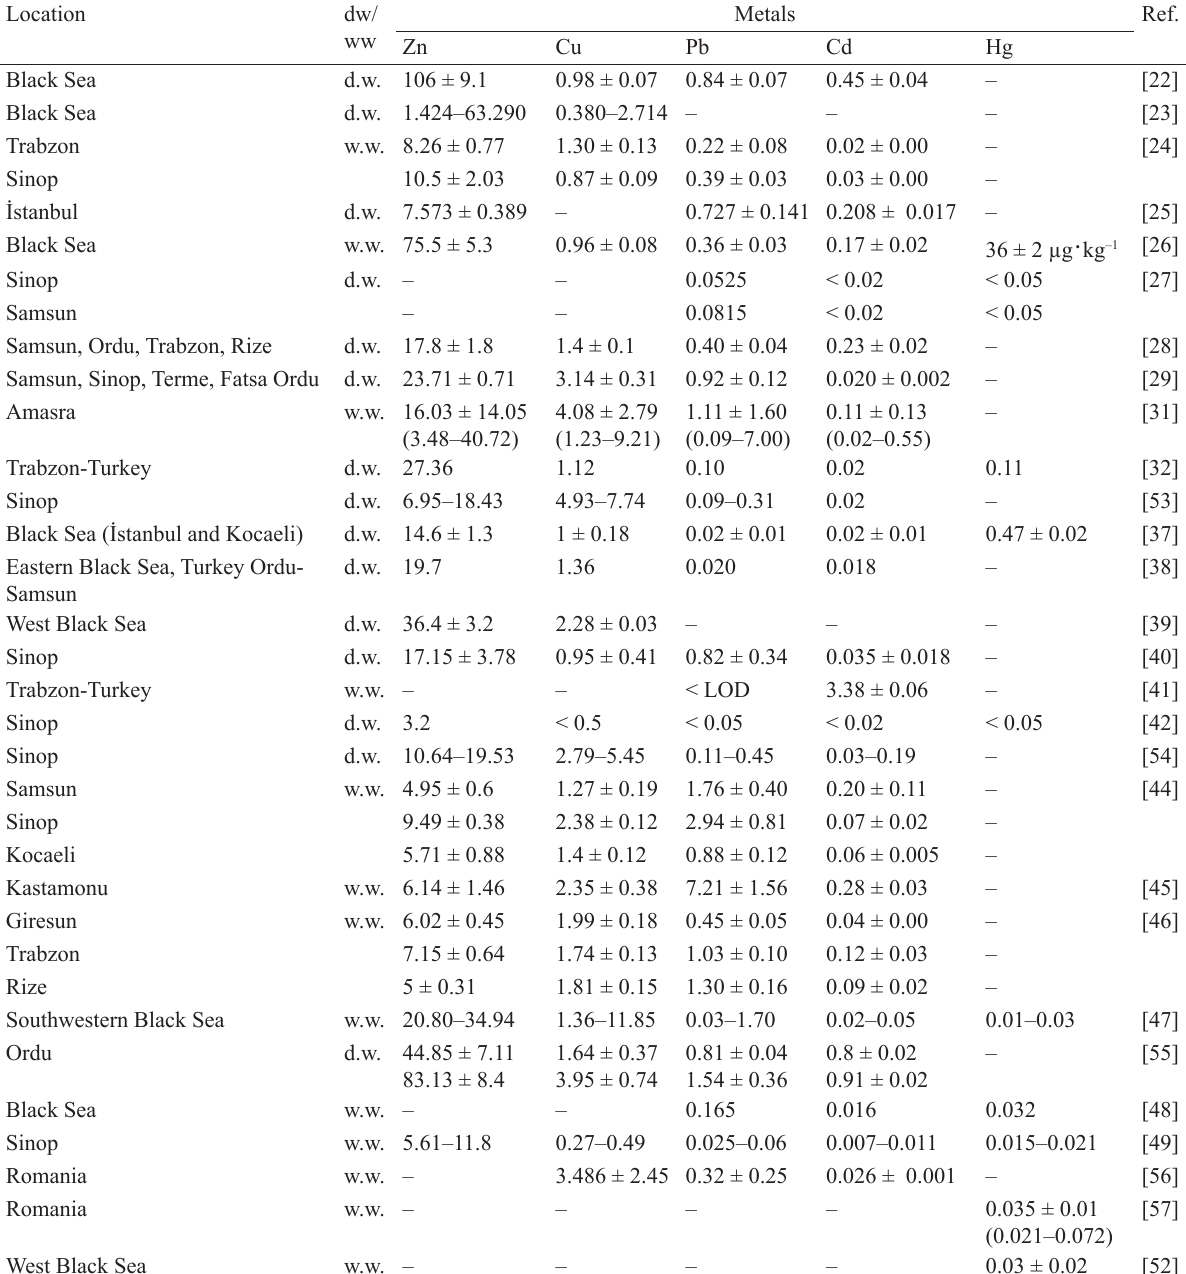
Table 8 Comparison of the amounts (ppm) of heavy metals in the edible tissues of Mullus barbatus L. caught near various areas of the Black Sea